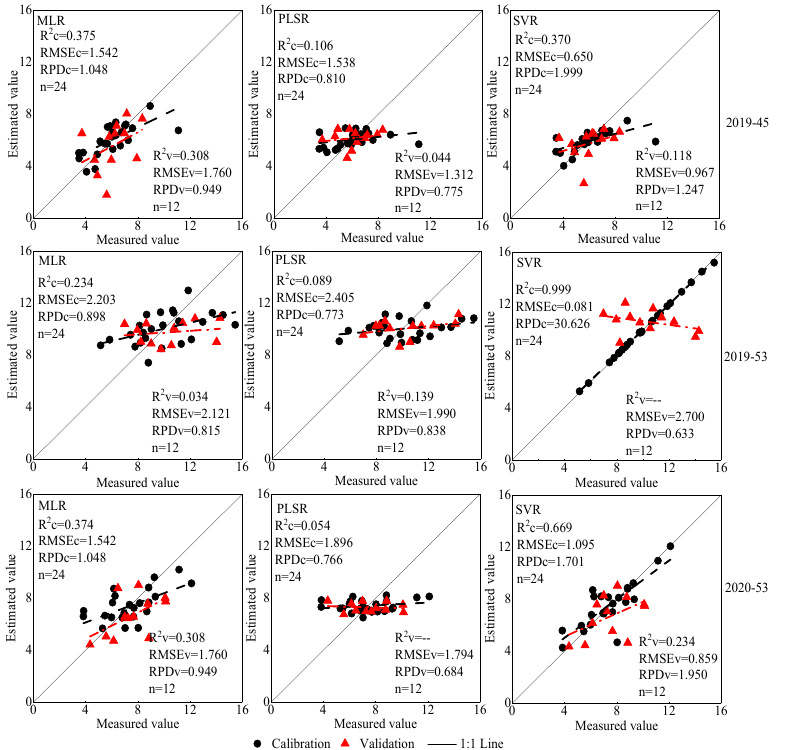
Figure 9. Vegetation index estimation and validation model parameters of canopy nitrogen density of drip ‐ irrigation cotton at the initial flowering stage.